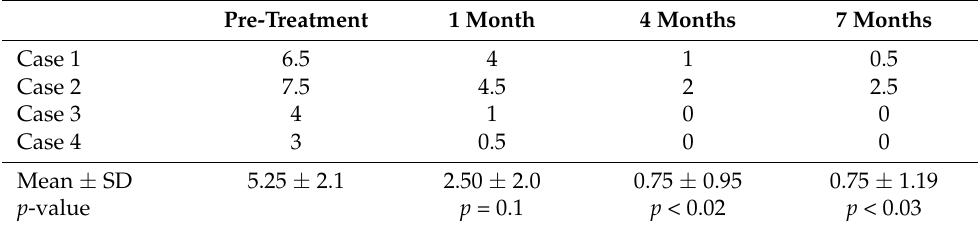
Table 5. Hyperesthesia suppressing treatment were performed once monthly. The mean and standard deviations of the VAS were calculated (mean ± SD). The significance of the differences between pre-treatment and after treatment (1, 4 and 7 months) was evaluated with p -values by t -test.